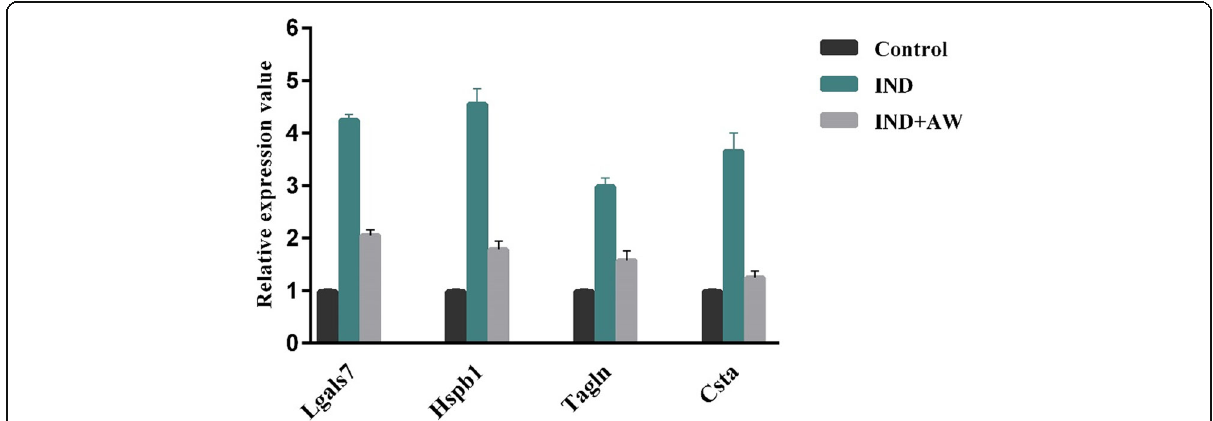
Fig. 6 Relative gene expression patterns of 4 differentially expressed proteins between I, I + AW and control groups by Real-Time PCR. The expression of Actin was used as the internal control gene. The values are as mean ± SD of three independent experiments ( P < 0.05). Lgals7: Galectin-7, Csta: Cystatin-A, Hspb1: Heat shock protein beta-1, Tagln: Transgelin. ( “ C ” : control group, “ I ” : rats with indomethacin-induced gastric ulcer, “ I + AW ” : ulcerated rats treated with AW